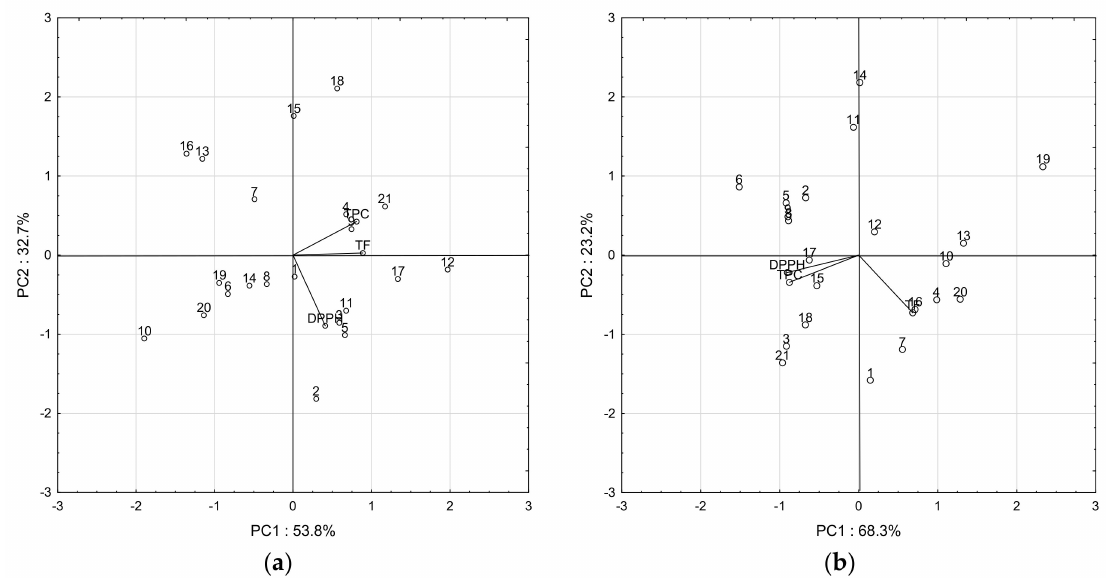
Figure 2. Principal component analysis of total polyphenol content (TPC), total flavonoid content (TFC) and antioxidant activity (DPPH) of extracts obtained with ( a ) scCO 2 or ( b ) scCO 2 /H 2 O. Points 1–21 present samples obtained from Helianthus salicifolius , Silphium perfoliatum, Helianthus tuberosus, Miscanthus × giganteus, Miscanthus sacchariflorus, Miscanthus sinensis and Spartina pectinate harvested in June (A), October (B) and February